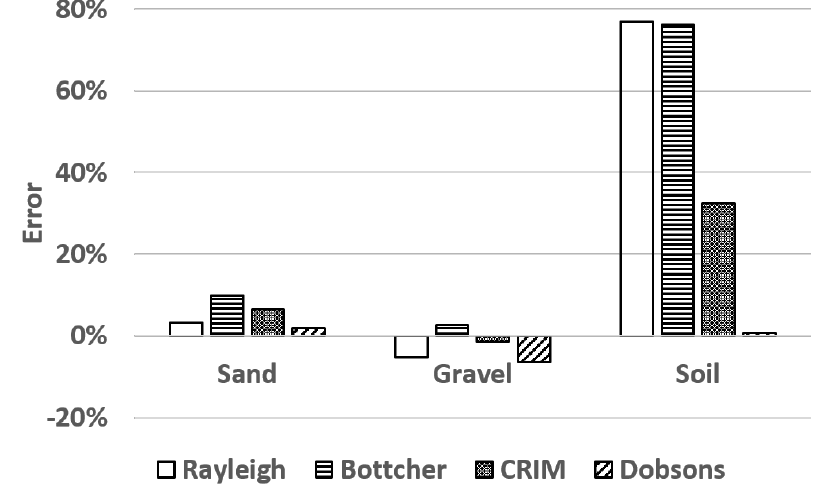
Figure 6. Error in the estimated bulk densities of the three materials under